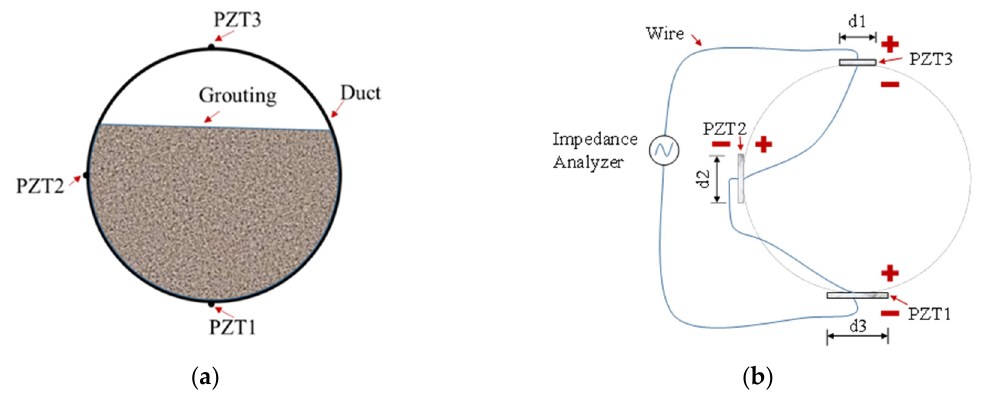
Figure 3. The schematic principle of monitoring of grouting compactness based on the multi-sensing EMI method. ( a ) Schematic; ( b ) Connection diagram of PZT patches.